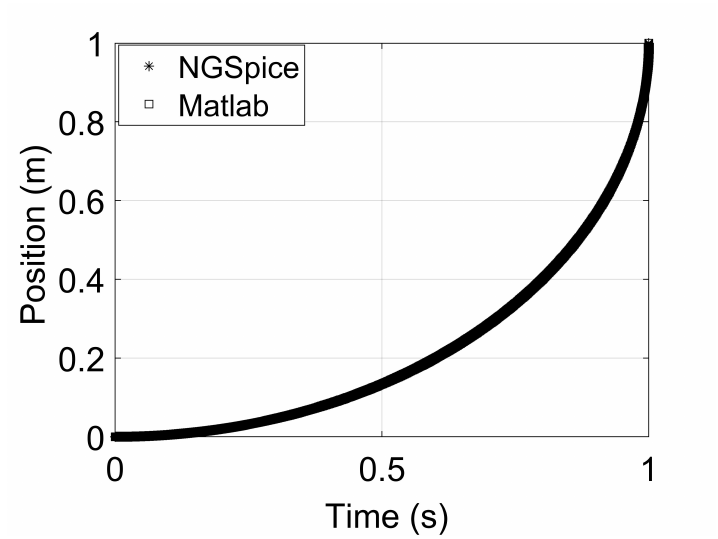
Figure 2. Circuit equivalent to equation with a = 0